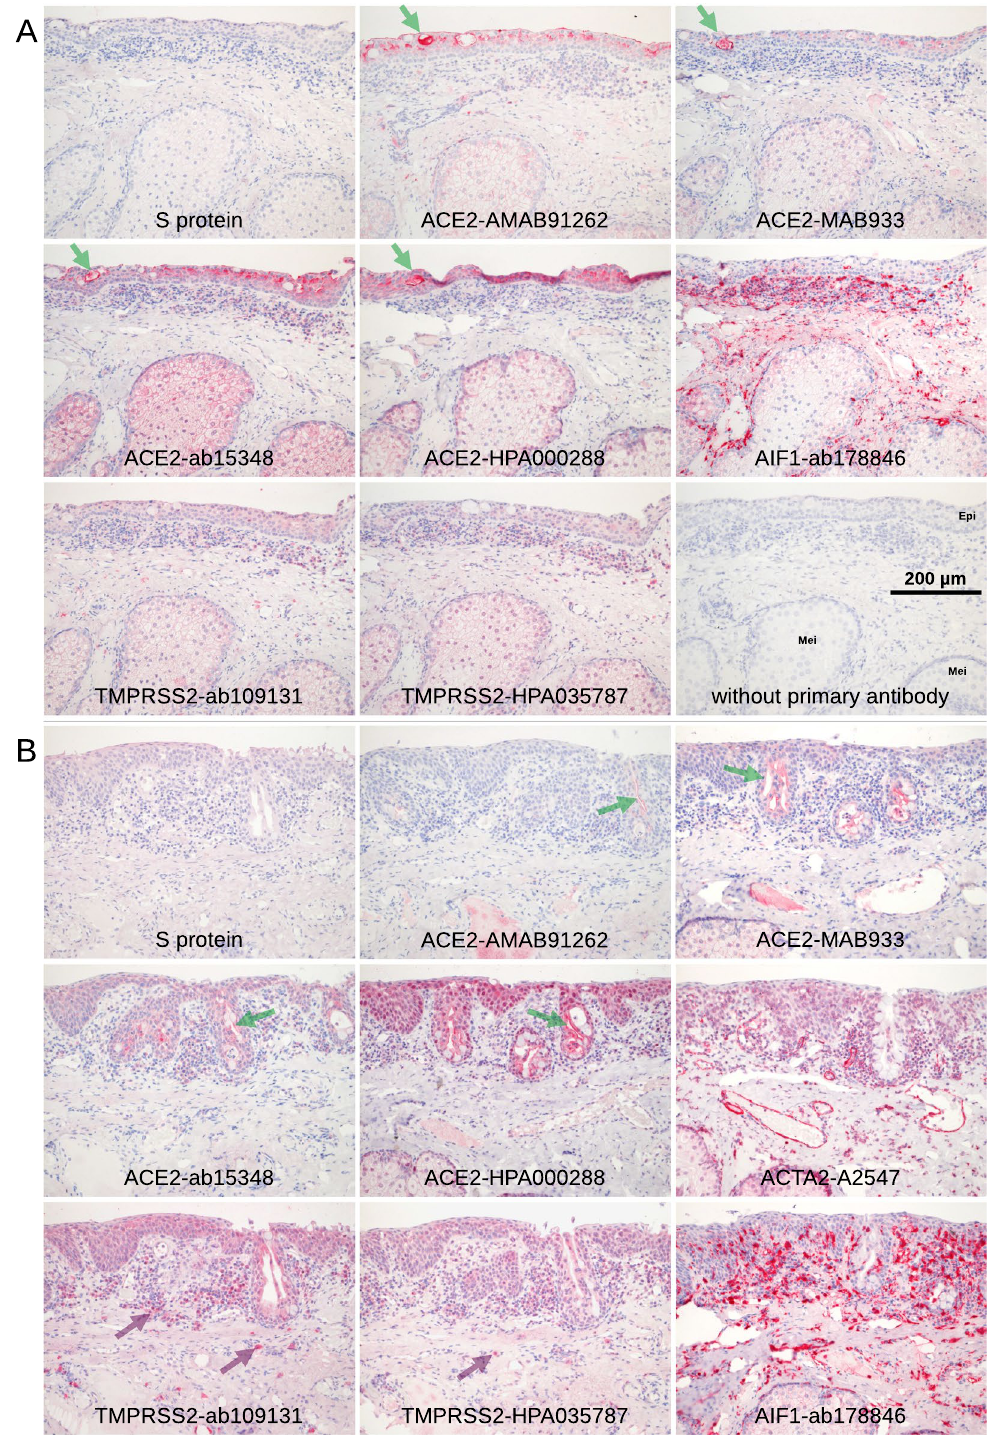
Figure 4. Eye lid. Serial paraffin sections were stained red with S protein or different antibodies raised against ACE2 or TMPRSS2. ( A ) Tarsal conjunctiva and Meibomian gland. S protein did not show any staining. A weak staining of the acinar cells of the Meibomian glands (Mei) was observed with all antibodies including AIF1 indicating that this weak staining is background. ACE2 and TMPRSS2 staining patterns differ. Their efferent ducts often showed a more intense staining in the extracellular sebaceous layer. Staining of the epithelium (Epi) was observed mainly in the tarsal part especially around Henle’s crypts. Staining of goblet cells within the epithelium (green arrows) was very rare (this case out of 8) and restricted to ACE2. ( B ) The glandular epithelial cells of the Henle’s crypts (green arrows) showed some staining that increased within the extracellular, luminal part. Antibodies TMPRSS2-ab109131 and TMPRSS2-HPA035787 stained macrophages (purple arrows). The level of background staining may be estimated from the staining for ACTA2 and AIF1 that showed intense staining in the vascular media layer and macrophages, respectively, in addition to a weak background including Meibomian glands and